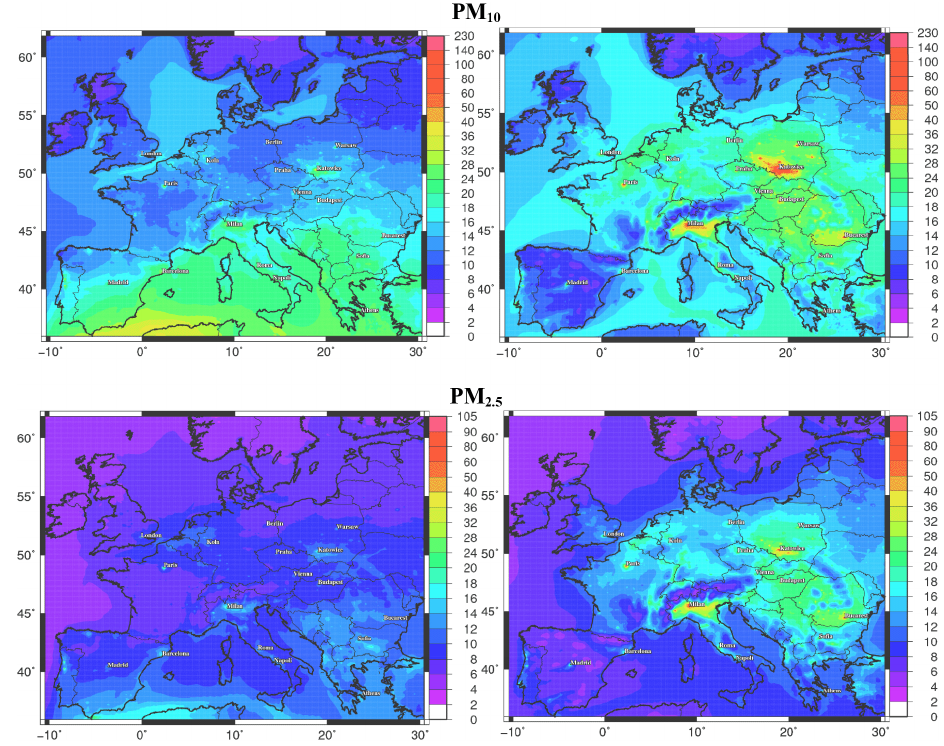
Figure 8. Modelled PM 10 and PM 2 . 5 (µgm − 3 ) concentrations fields calculated for the summer (left) and the winter (right) seasons.